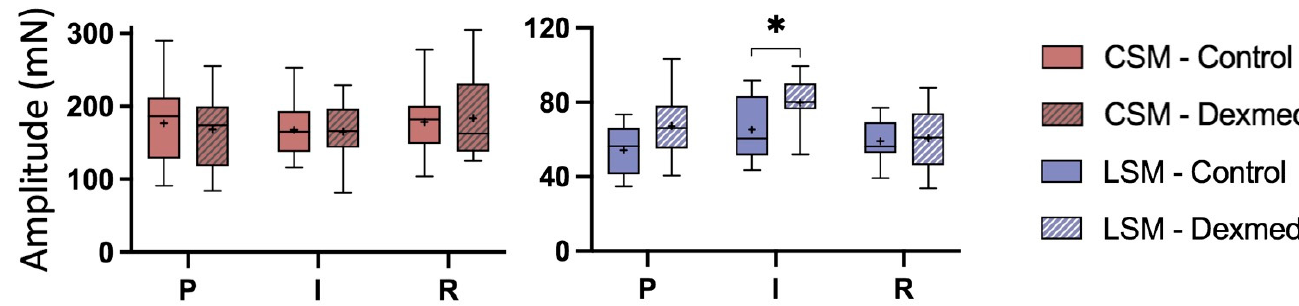
Figure 7. Box plot diagram of the nerve mediated contractile activity of jejunal circular smooth muscle (CSM) and longitudinal smooth muscle (LSM) during pre-ischaemia (P), ischaemia (I), and reperfusion (R) at t110 with and without the addition of dexmedetomidine (Dexmed). Significant differences between the control group and the Dexmed-treated group (two sample t -test) are marked with an asterisk (* p < 0.05). The horizontal bar displays the median and the plus is the mean, the interquartile range is represented by the box and the minimum and maximum by the whisker plots.